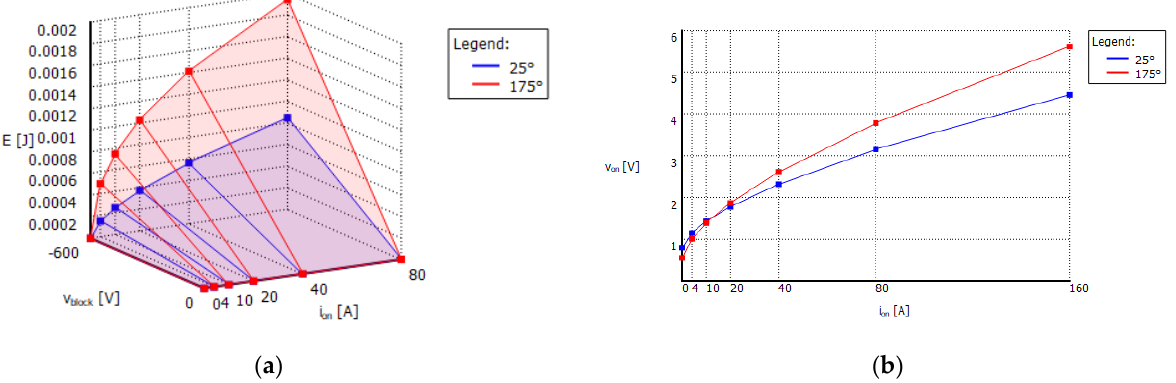
Figure 12. Diode thermal description corresponding to ( a ) Turn OFF losses and ( b ) conduction losses.